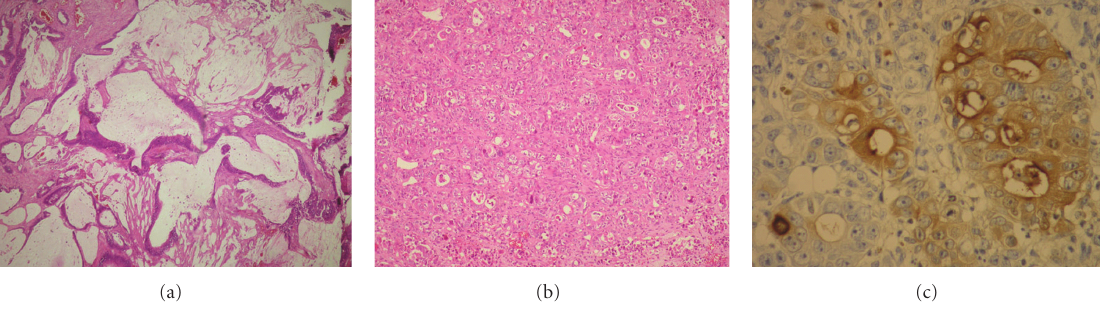
Figure 4: (a) Mucinous adenocarcinoma of the rectum, 5 years ago. (H&E × 200), (b) low di ff erentiated metastatic adenocarcinoma (H&E × 200), (c) immunohistochemical staining with monoclonal CEA positiveness (DAB chromogen ×